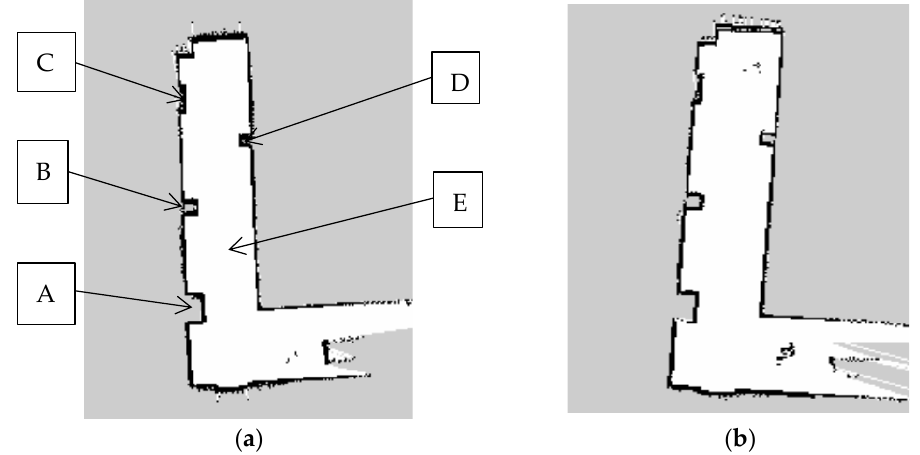
Figure 24. ( a ) Mapping effect with 60 particles. ( b ) Mapping effect with 80 particles. In the raster map, black represents areas with static obstacles, white represents areas without static obstacles, and gray represents unknown areas that have not yet been